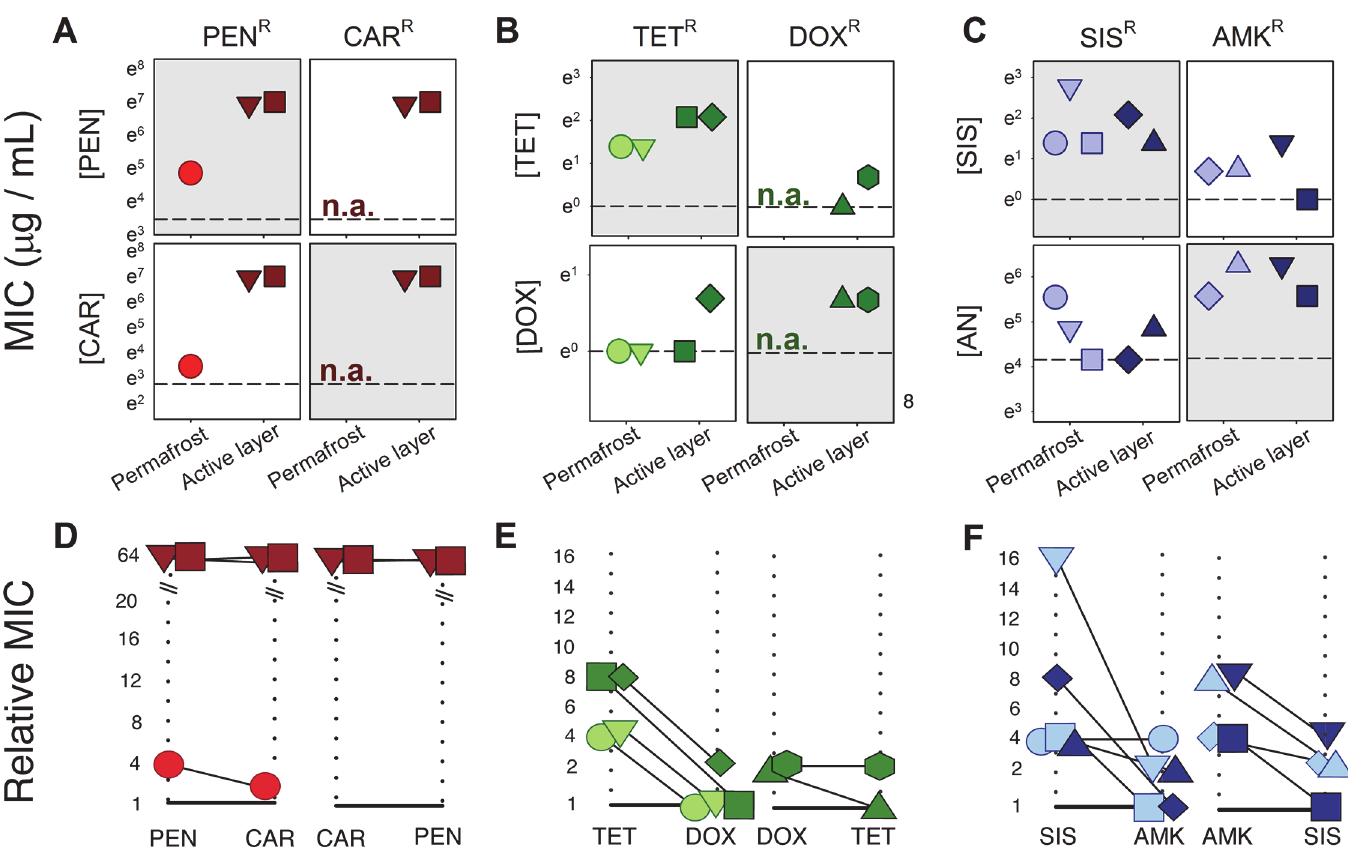
Fig 4. Resistance (A-C) and cross-resistance (D-F) levels of resistance genes isolated from ancient permafrost and its overlaying active layer. Each unique gene is depicted by a shape and color combination based on sampling site and antibiotic on which it was isolated (shown on top of panels): A) & D) β -lactams, penicillin (PEN) & carbenicillin (CAR); B) & E) tetracyclines, tetracycline (TET) & doxycycline (DOX); and C) & F) aminoglycosides, sisomicin (SIS) & amikacin (AMK). In panels A) to C), each point shows resistance to antibiotics indicated at left (measured as minimum inhibitory concentration, MIC). Grey panels indicate resistance levels to the drug in which genes were isolated, and white panels show cross-resistance to the other drug in the same class. Dashed line indicates MIC of control libraries. Panels D) to F) show slopegraphs of cross-resistance between antibiotics of a same family. The left axis represents relative resistance (MIC of the isolated genes / MIC of the control E . coli library) in the antibiotics where the gene was isolated. The right axis represents the relative fitness of the genes in the other antibiotic of the same class. Any slope that doesn ’ t go down to one on the right axis indicates some degree of cross-resistance.